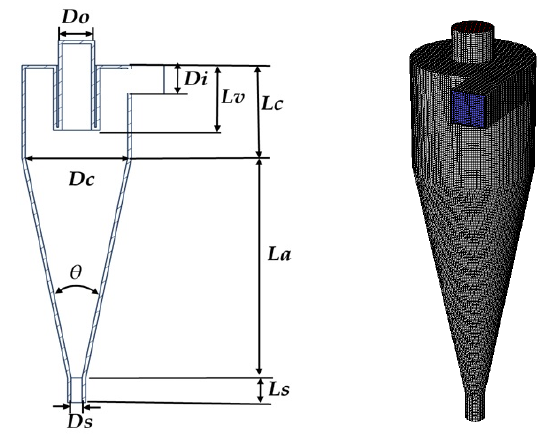
Figure 3. Geometric dimensions and domain mesh.